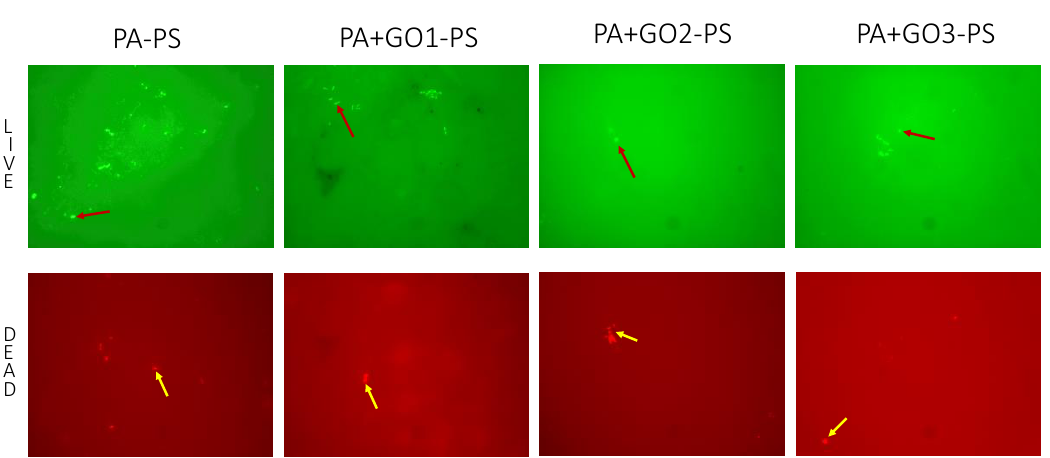
Figure 8. Fluorescent bacteria images of membranes with the dead/live detection kit.